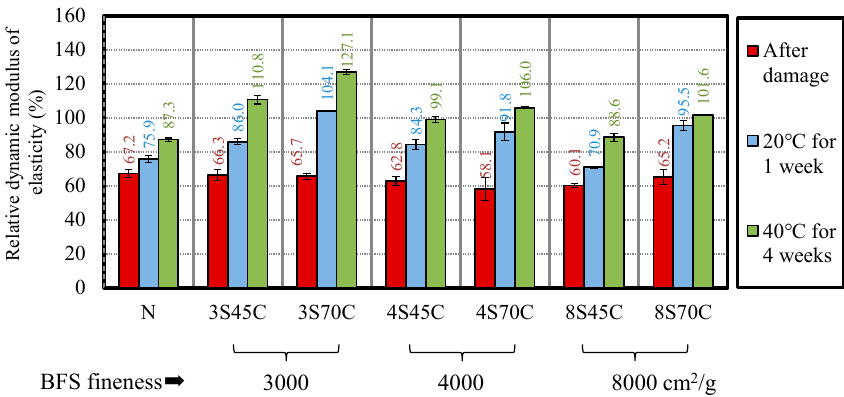
Figure 13. Changes in relative dynamic modulus of elasticity after damage and after water curing.